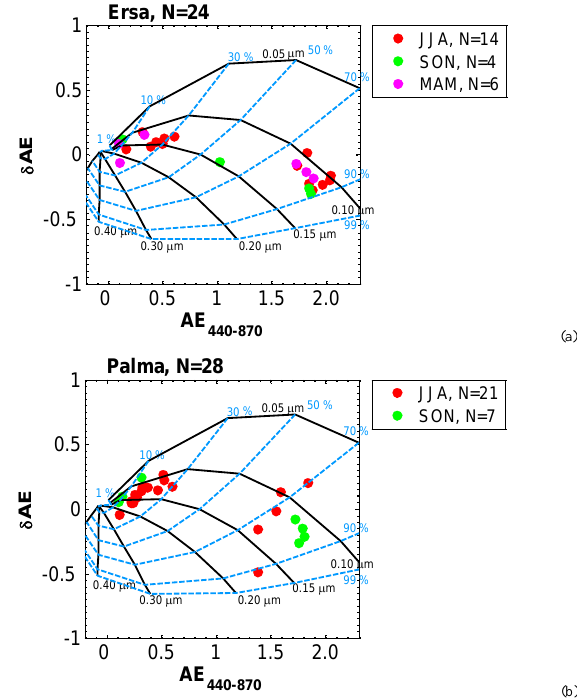
Figure 8. Ångström exponent difference ( δ AE = AE 440 − 675 – AE 675 − 870 ) as a function of the Ångström exponent calculated be- tween 440 and 870nm (AE 440 − 870 ) at (a) Ersa and (b) Palma, de- rived from AERONET level 2.0 daily inversion products available for the period 2011–2015, which means that the following criteria apply on these data: 50<solar zenith angle<80 ◦ and aerosol op- tical depth at 440nm (AOD 440 ) >0.4. A bimodal, lognormal size distribution and a refractive index of 1.4–0.001 i are considered to construct the grid. The black solid lines are each for a fixed fine- mode radius and the dashed blue lines for a fixed fraction of the fine-mode contribution to the AOD at